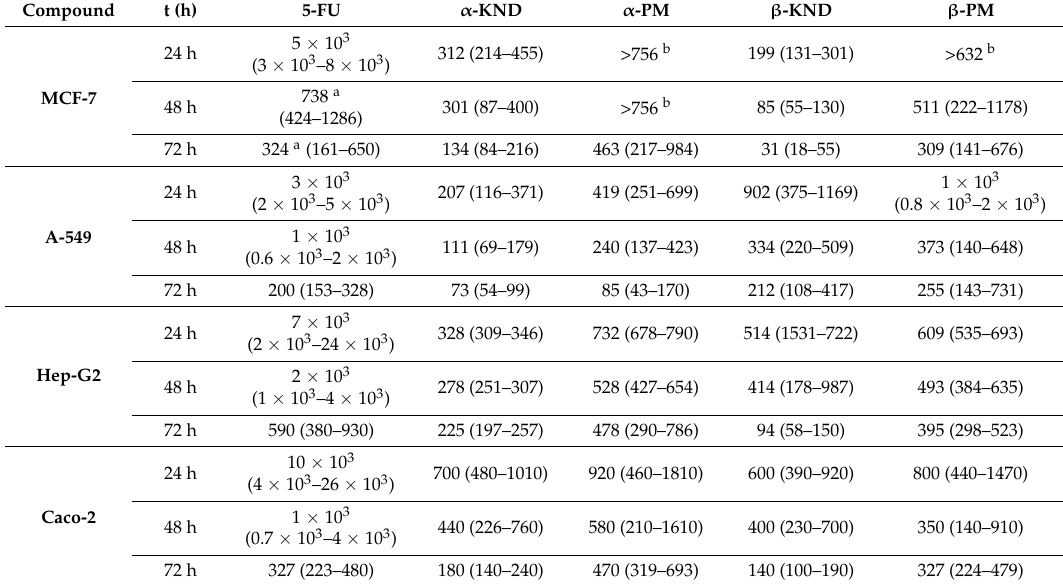
Table 2. IC 50 values of cytotoxicity tests on MCF-7, A-549, Hep-G2, and Caco-2 cell lines for 5-FU, α -KND, β -KND, α -PM, and β -PM in µ M with 95% confidence range (in brackets) from 24 to 72 h.